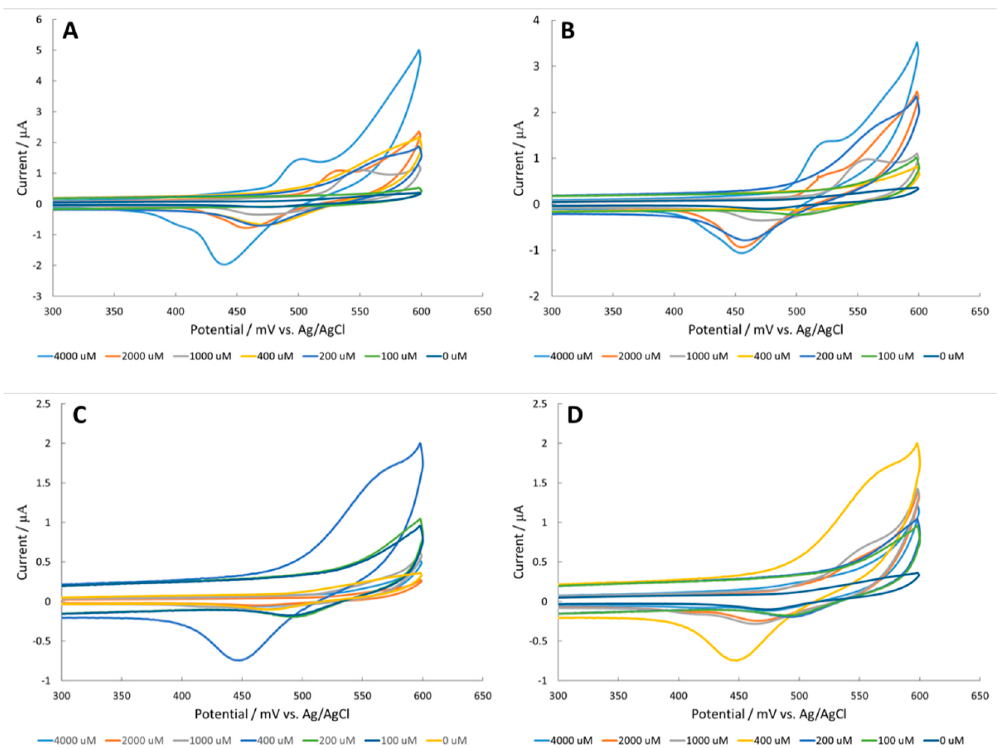
Figure 5. CV of ( A ) alanine, ( B ) arginine, ( C ) serine, and ( D ) valine in 100 mM NaOH with NiO modified glassy carbon electrode.